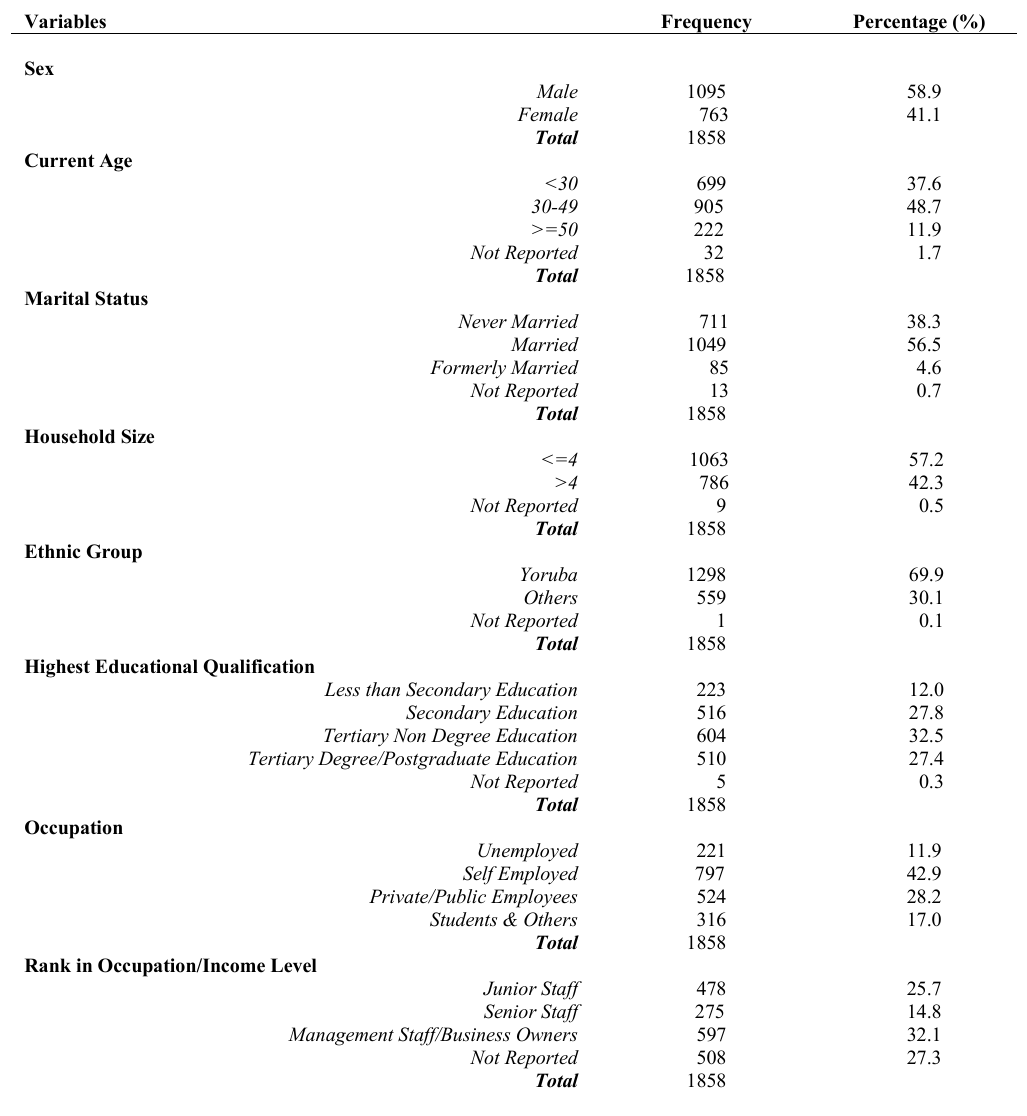
Table 1: Socio-demographics Characteristics of Respondents